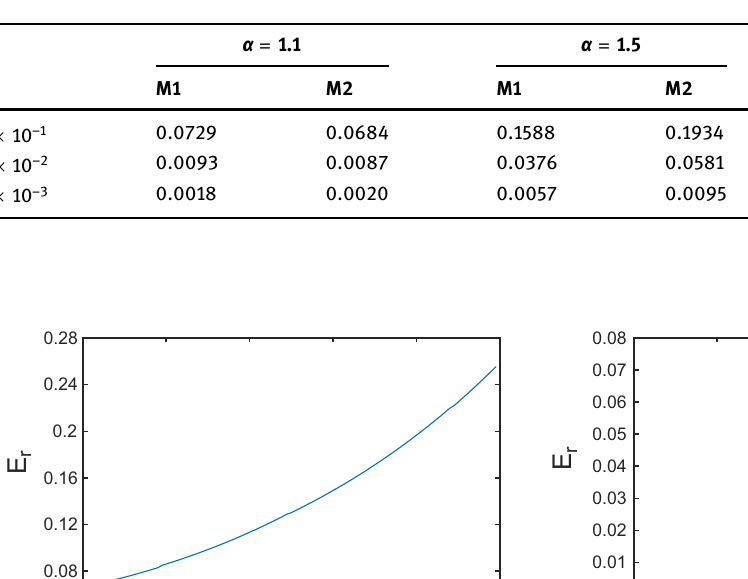
Table 1: The relative errors of Example